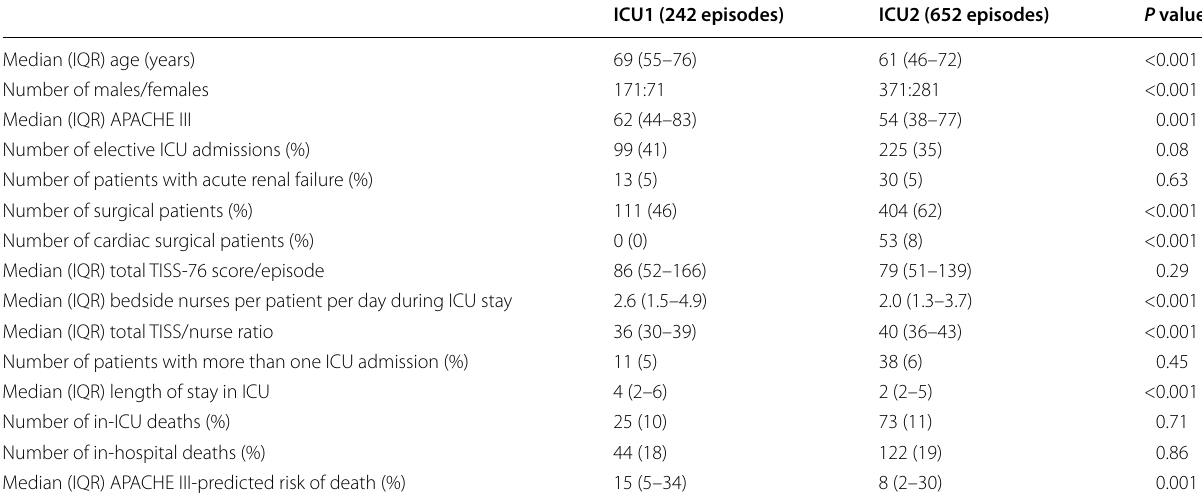
IQR interquartile range, APACHE III Acute Physiology and Chronic Health Evaluation III, TISS-76 76 item Therapeutic Intervention Scoring